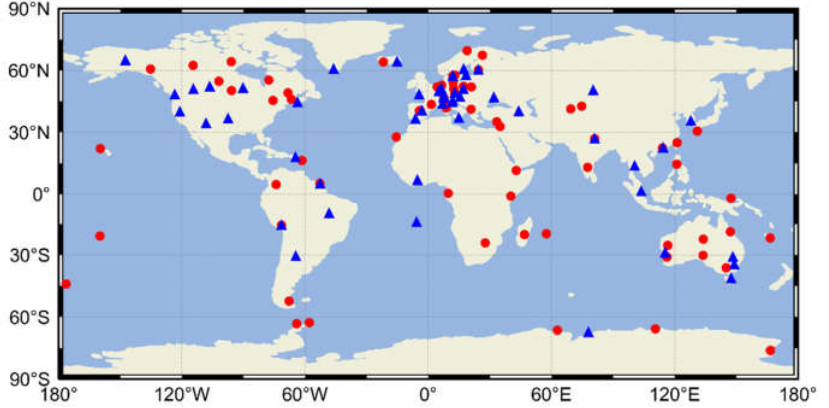
Figure 1. Overview of the experimental stations. Red circles denote 70 stations for satellite clock estimation, and blue triangles denote 57 stations for PPP experiment. The observation data are obtained from the IGS MGEX networks.